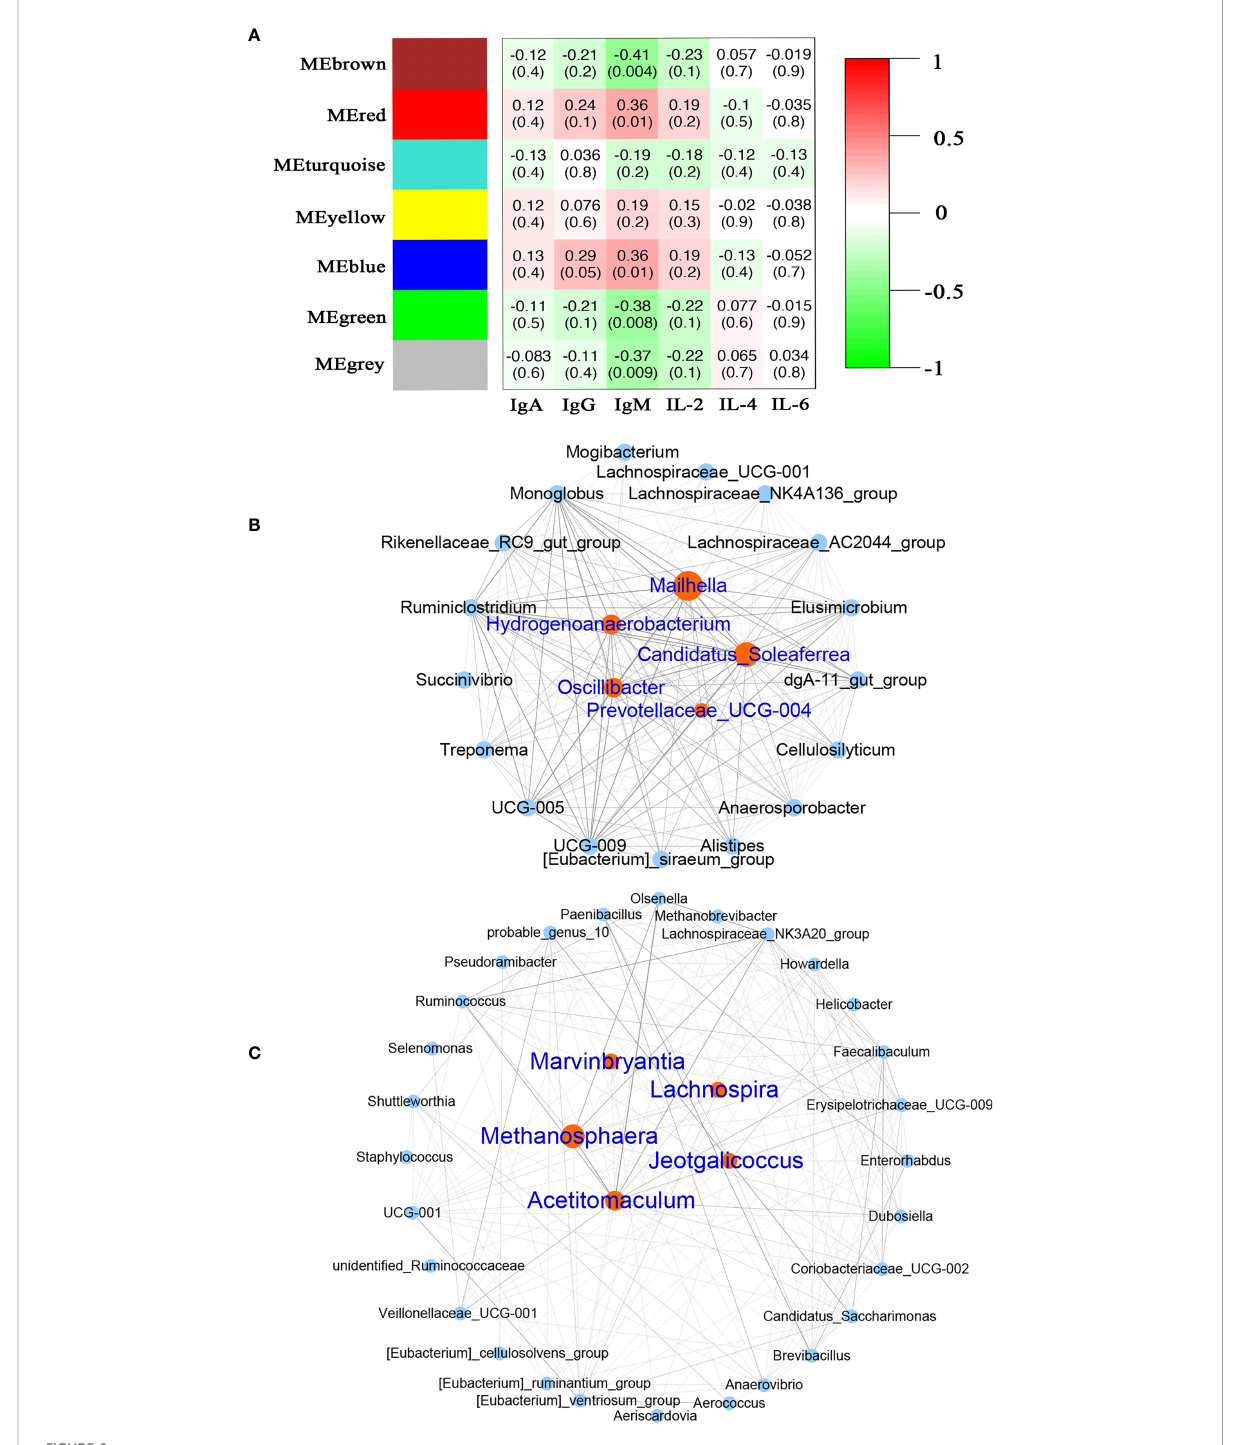
FIGURE 6 Correlation between the serum immune factors and abundance of microbiome in rumen and feces at the genus level. The correlated module was analyzed using a weighted gene co-expression network analysis (WGCNA). Correlation networks were generated using Spearman ’ s rank correlation coef fi cients. (A) The heatmap of the WGCNA module. (B) Microbiome interaction network and hub microbes in the MEred module. (C) Microbiome interaction network and hub microbes in the MEblue